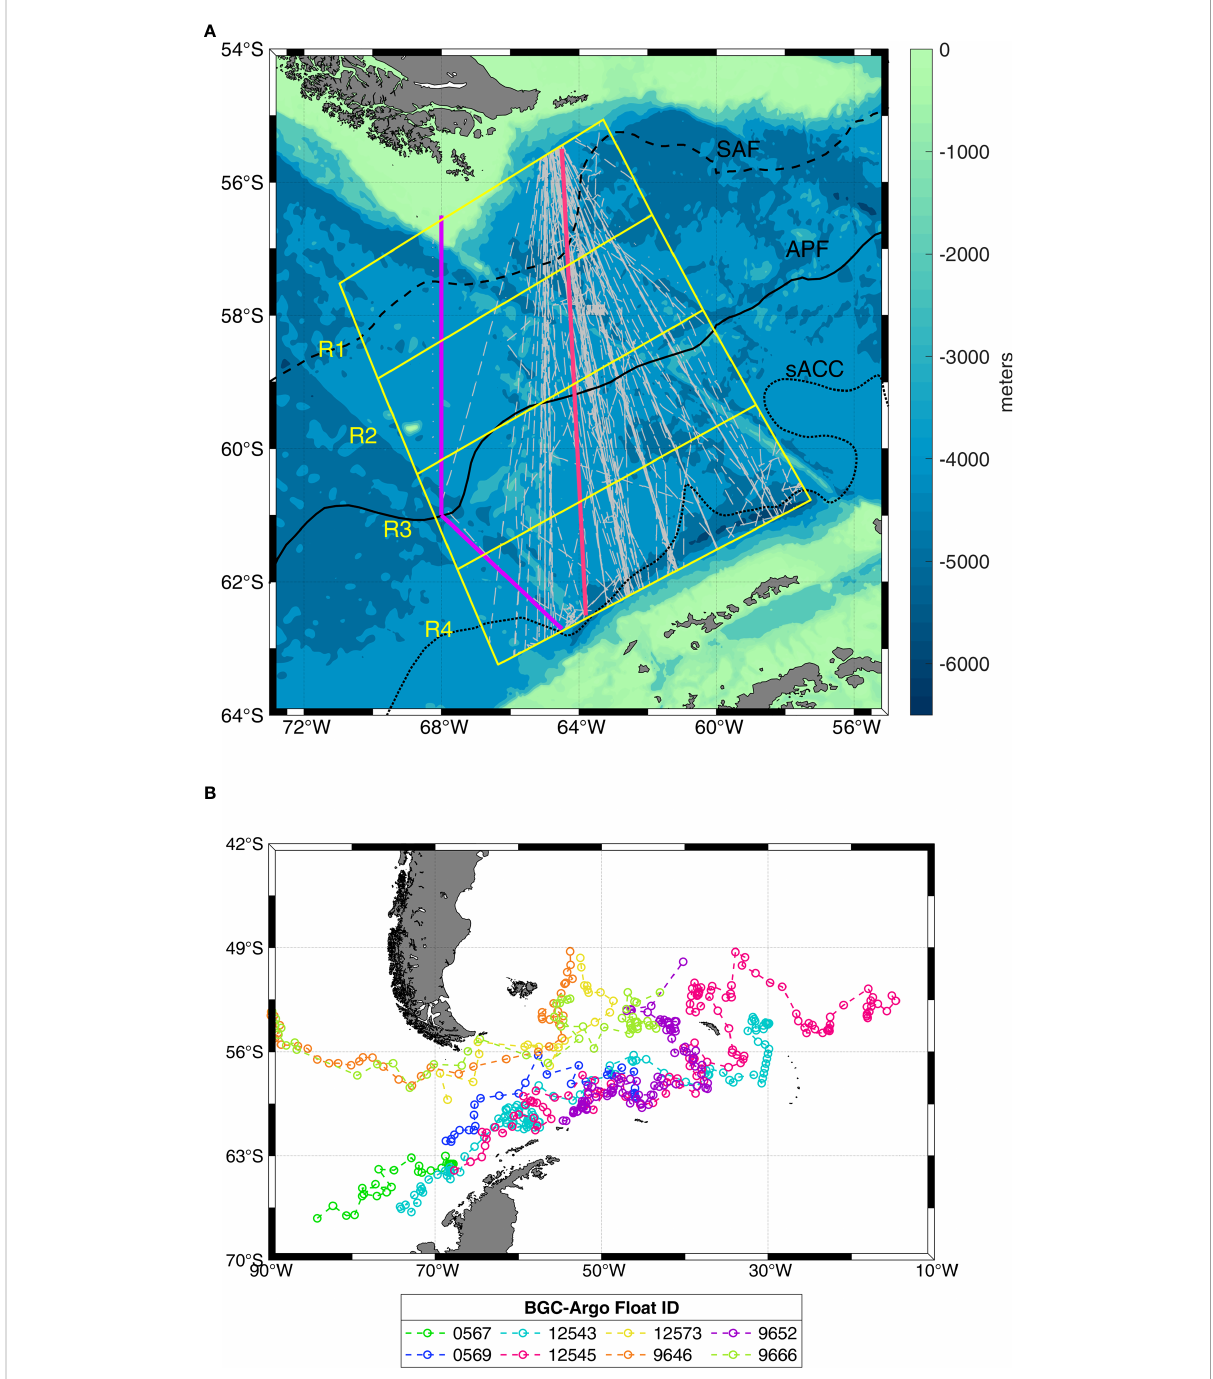
FIGURE 1 The observations from ship-based underway measurements and biogeochemical-Argo fl oat in the Drake Passage. (A) underway p CO 2 measurements indicated by grey lines. The black dashed line indicates the location of SAF, black solid line indicates APF, and black dotted line indicates southern ACC front (front data obtained from Orsi et al., 1995; Thorpe et al., 2002). The cruises with water column sampling are denoted by purple and pink lines, in February 2009 and March 2006/September 2009, respectively. The coordinates of the box corners from the top corner of R1 to the bottom corner of R4 are: 55.06°S, 63.29°W; 57.52°S, 70.97°W; 56.49°S, 61.87°W; 58.95°S, 69.85°W; 57.92°S, 60.39° W; 60.38°S, 68.71°W; 59.34°S, 58.85°W; 61.81°S, 67.54°W; 60.77°S, 57.26°W; and 63.24°S, 66.35°W. (B) Argo fl oats that intersected the study area. Eight fl oats were